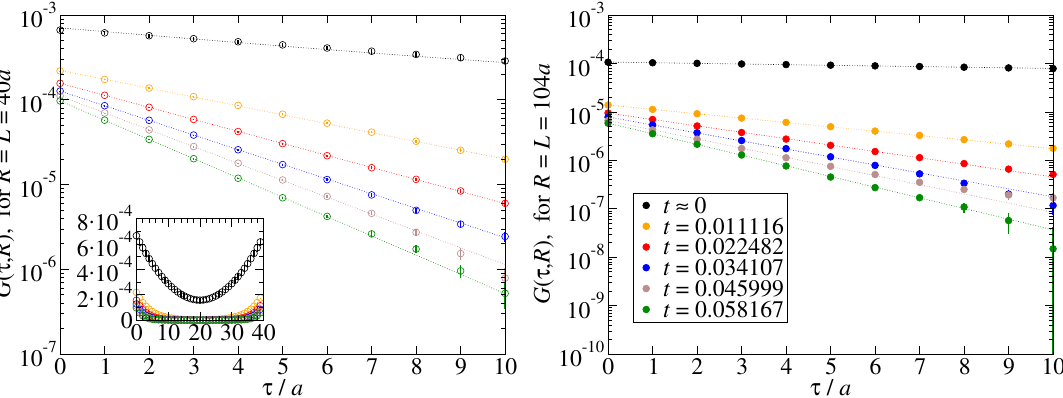
Figure 1 . Euclidean-time-separation dependence of the two-point correlation function of zero- momentum operators defined in eq. (2.1), on lattices of size L 4 = (40 a ) 4 (left-hand-side panel, open symbols) and L 4 = (104 a ) 4 (right-hand-side panel, full symbols), for different values of the reduced temperature t = ( T − T ) /T , denoted by different colors, in the symmetric phase. The curves are c c obtained from two-parameter fits of our Monte Carlo simulation results to the expected functional form in eq. (2.3). The inset in the left-hand-side panel shows the results for the correlation function for all values 0 ≤ τ < L